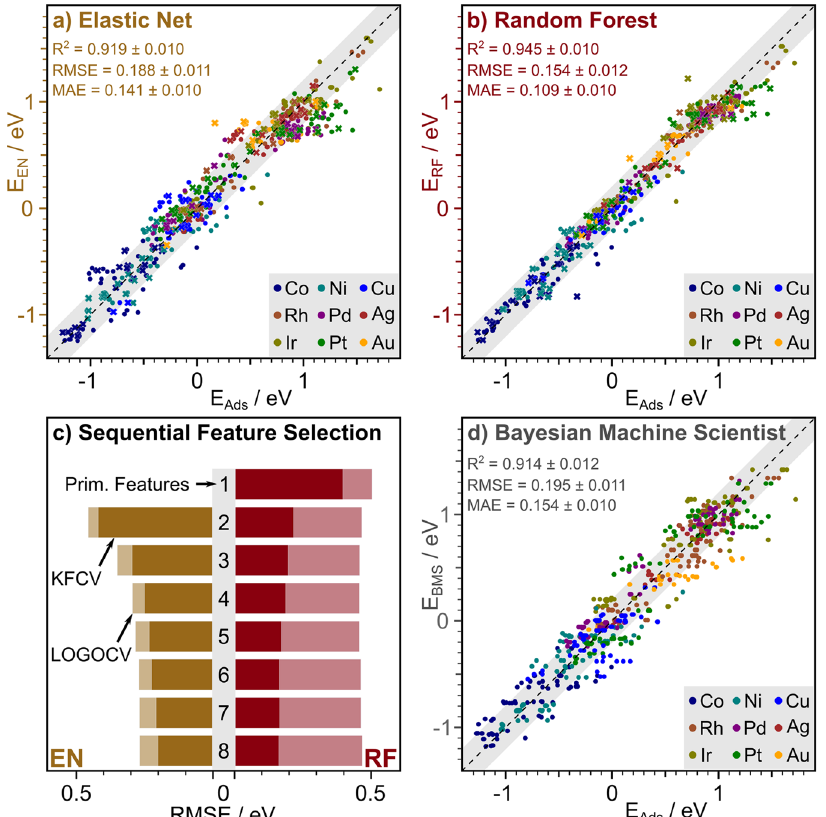
Fig. 3 Predictive ML models constructed from the DFT dataset of adsorption energies ( E Ads ) of ground and excited states of ceria-based group 9 – 11 transition metal (TM) SACs. Predictions by the best-performing Elastic Net (EN), Random Forest (RF), and Bayesian Machine Scientist (BMS) models are shown in the panels a , b , and d , with training (testing) data points indicated as circles (crosses). The gray areas mark a region with a deviation of up to 0.2 eV. Panel c shows the courses of RMSE values for the EN and RF models during sequential feature selection (SFS), evaluated via K-fold cross-validation (KFCV; opaque bars) and leave-one-group-out cross-validation (LOGOCV; transparent bars). The use of secondary features for Elastic Net (see main text) requires a minimum of two descriptors in the reduced primary space. The actual error values and selected primary features obtained during SFS, panel c , are listed in Supplementary Table